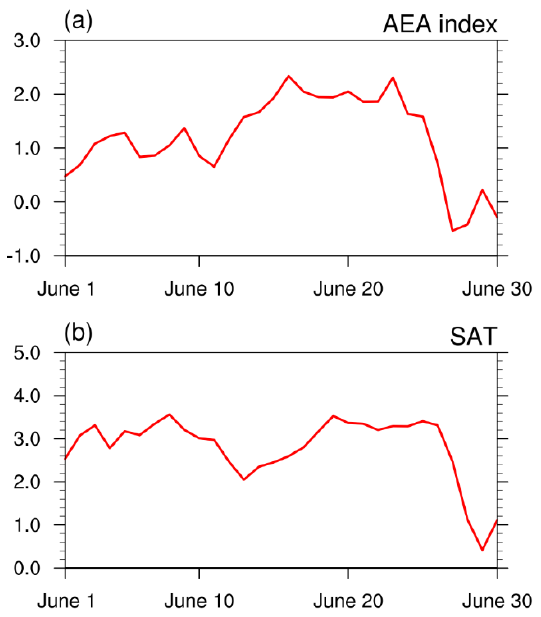
Figure 8. Daily evolutions of ( a ) AEA index and ( b ) SAT anomalies averaged over Europe from 1st to 30th June in 2019.